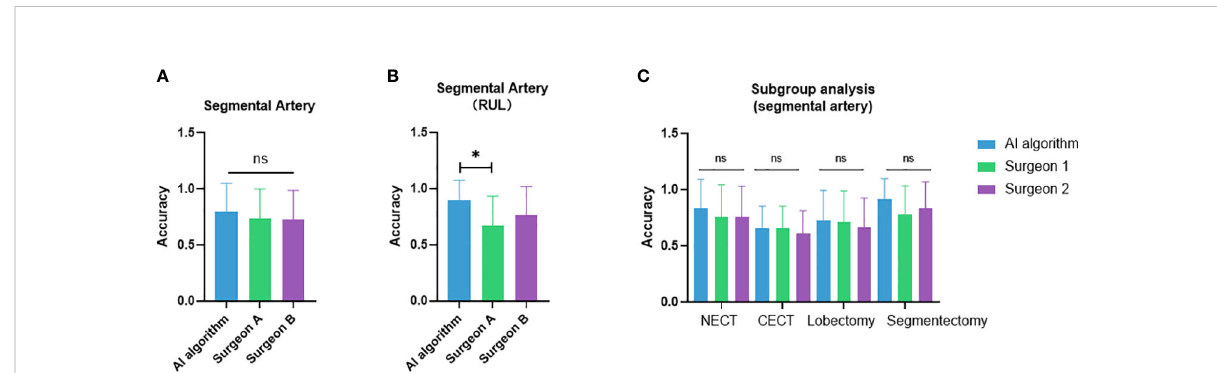
FIGURE 4 Performance comparison between the arti fi cial intelligence algorithm and two surgeons. (A) Three-way analysis between three groups; (B) Pairwise analysis showed signi fi cantly lower accuracy in the RUL of surgeon A compared to the AI algorithm; (C) subgroup analysis between non-contrast vs. contrast CT and lobectomy vs. segmentectomy. NECT, non-enhanced CT; CECT, contrast-enhanced CT. *p<0.05; ns, non-signi fi